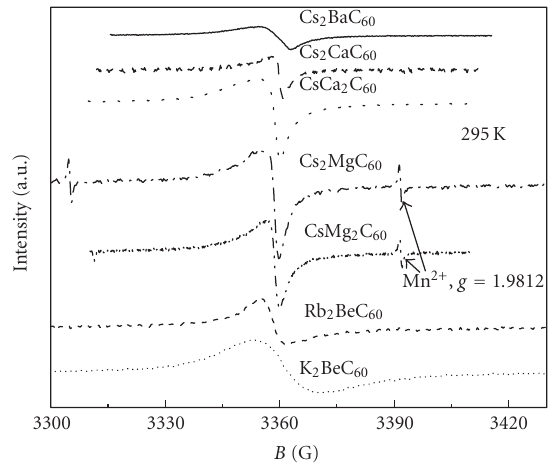
Figure 5: Asymmetric of EPR spectra heterofullerides with Cs pointed out to asymmetric environment of molecule C 60 due to possible polymerization.